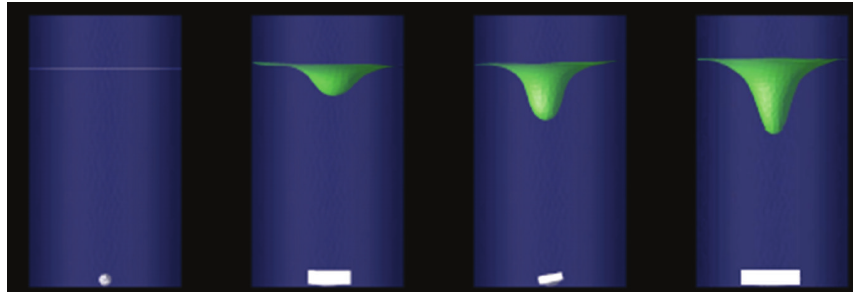
Figure 7: Vortex formation after stirrer startup.